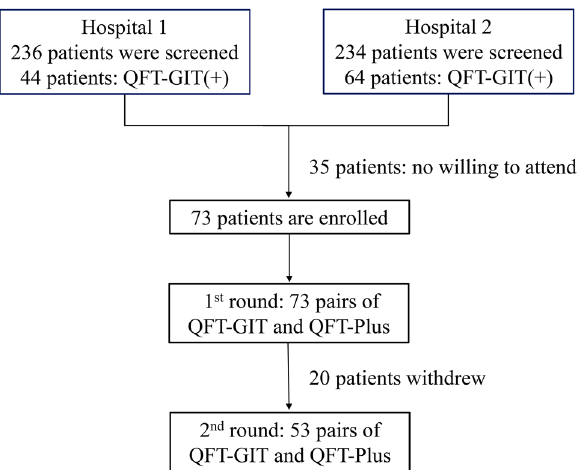
Figure 1. Flowchart of participant enrollment. QFT-GIT, QuantiFERON-TB Gold In-tube; QFT-Plus, QuantiFERON-TB Gold